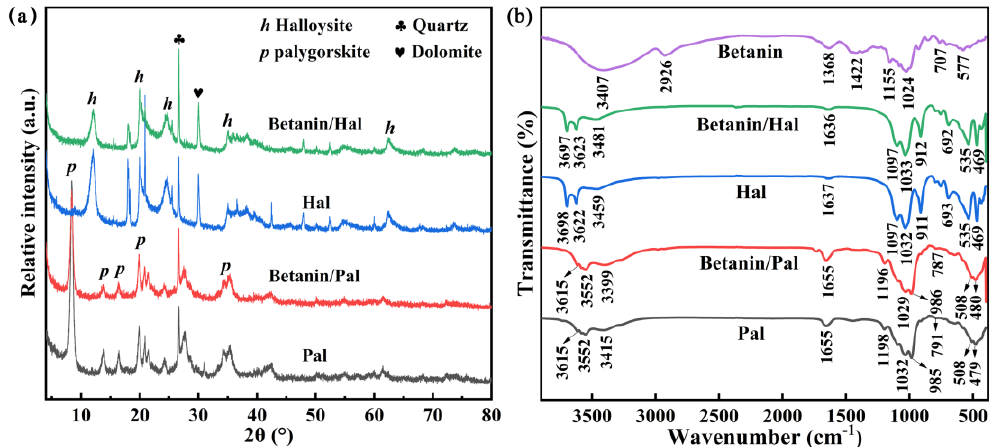
Figure 3. ( a ) XRD patterns and ( b ) FTIR spectra of betanin, clay minerals and hybrid materials.